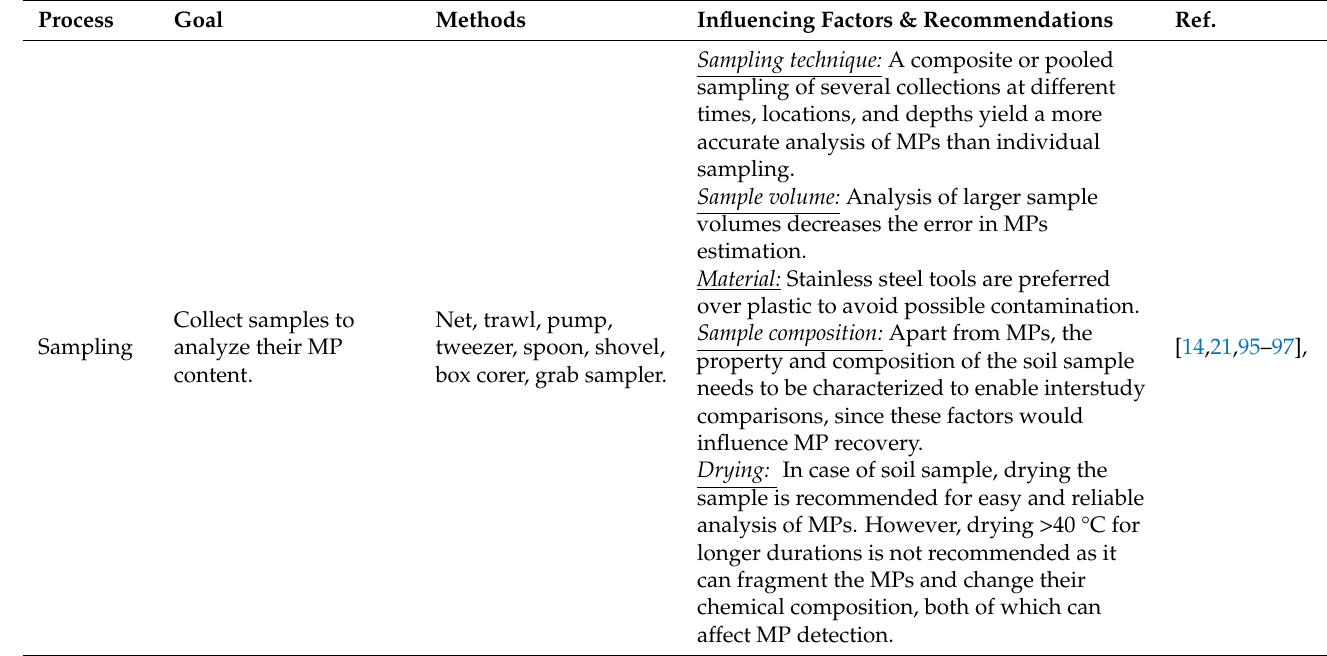
Figure 3. Schematic representation of MPs toxicity, and steps involved in the process flow of MPs analysis. Excerpted with permission from Xiang, S et al., Identification and quantification of microplastics in aquaculture environment, Front. Mar. Sci. 2022 , 8 . https://creativecommons.org/licenses/by/4.0/, accessed on 18 January 2023. Table 2. Summary of various steps involved in the process flow of MPs analysis, and recommended practices based on research